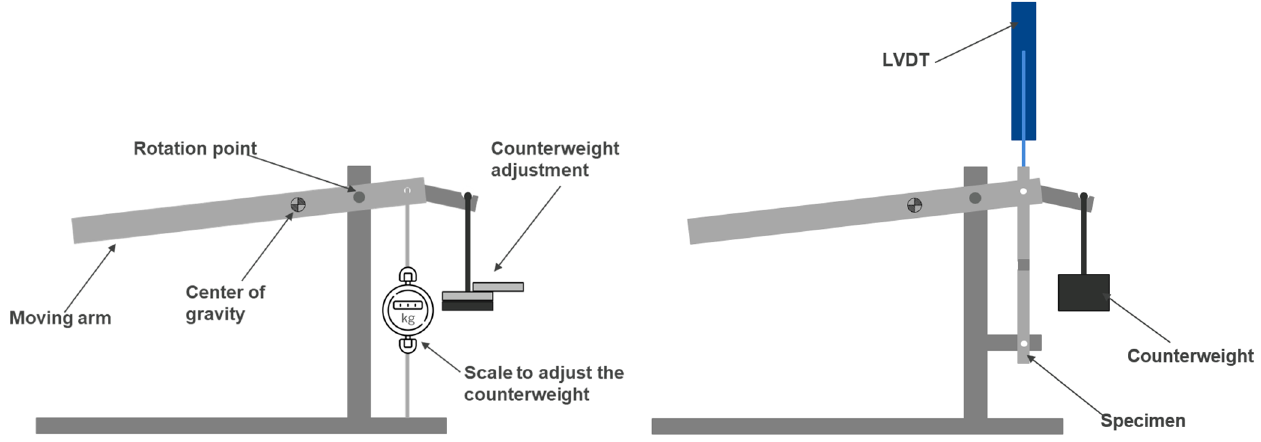
Figure 4. Static creep machine representative scheme: counterweight adjustment ( left ) and unit ready to test ( right ).